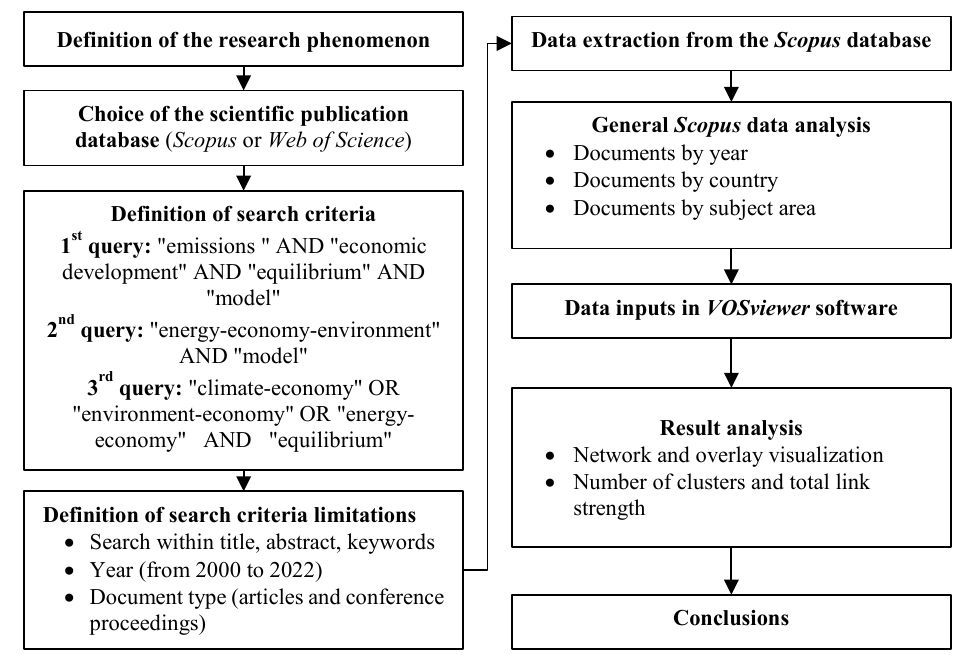
Fig. 1. Main steps of bibliometric research